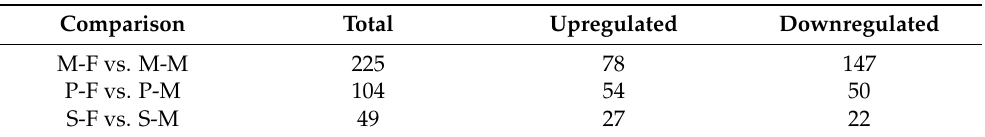
Table 2. Summary of the DEGs from male (-M) and female (-F) comparisons in metacarpal (M), perirenal (P) and prescapular (S) adipose tissues of Even (E) reindeer.